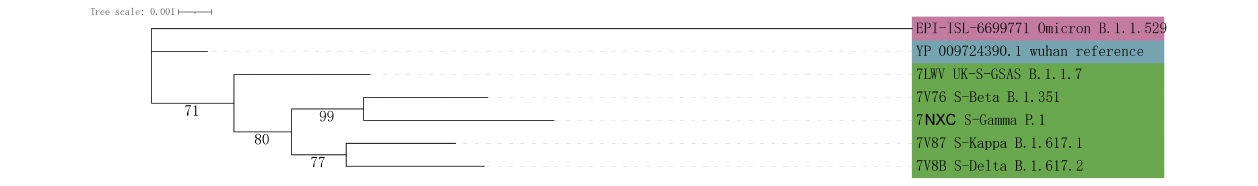
FIGURE 3 | Phylogenetic tree of 7 SARS-CoV-2 variants based on their spike protein sequences. The branch length represents the number of substitutions per site, with the positions containing gaps and missing data being